Question: Give a one-sentence summary of this figure.
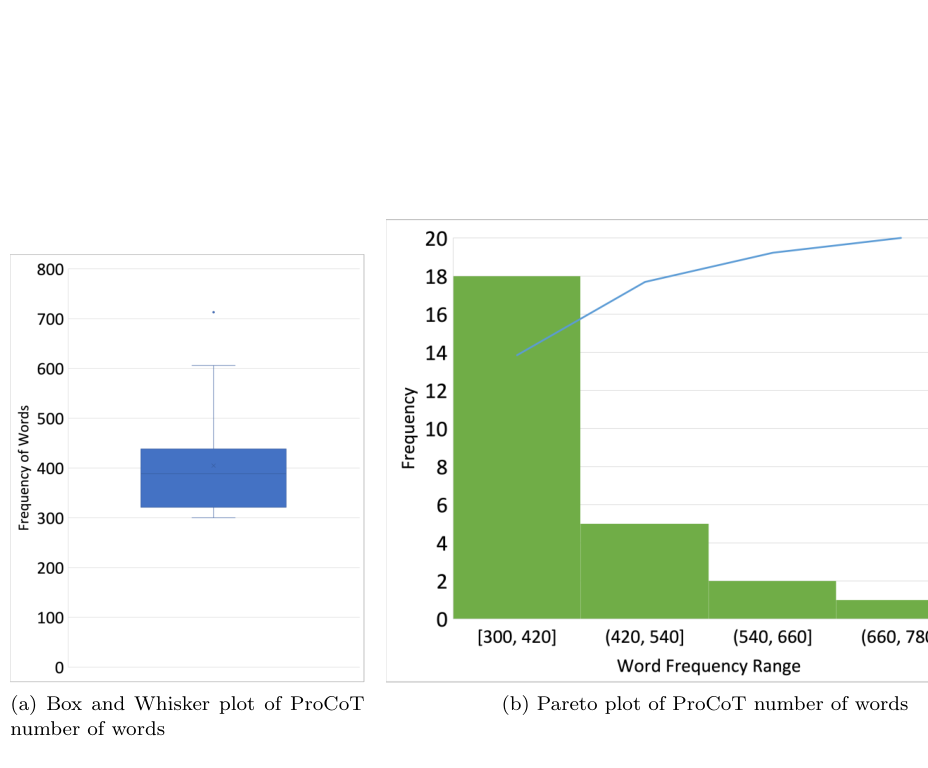
Answer: Case 2: Quantitative plots of ProCoT number of words in student answers.